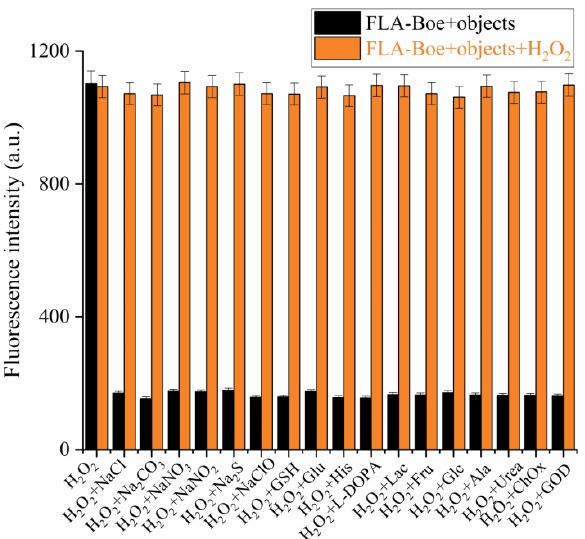
Figure 4. The fluorescence intensity contrast bars in order to investigate the interference effect of other test objects on the detection ability of FLA-Boe for H 2 O 2 . other test objects on the detection ability of FLA-Boe for H